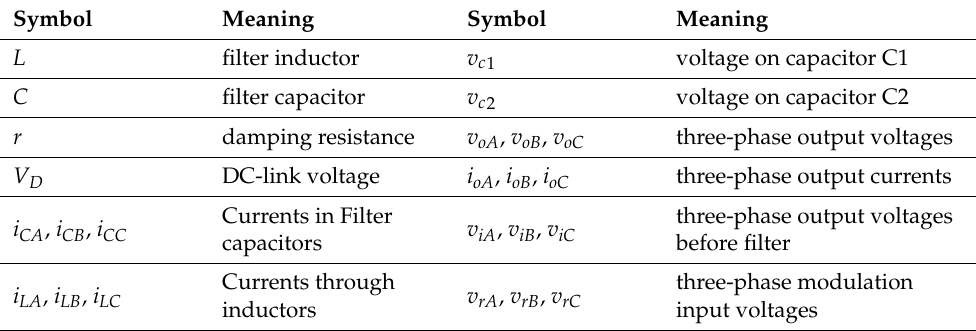
Table 4. Symbols in the mathematical